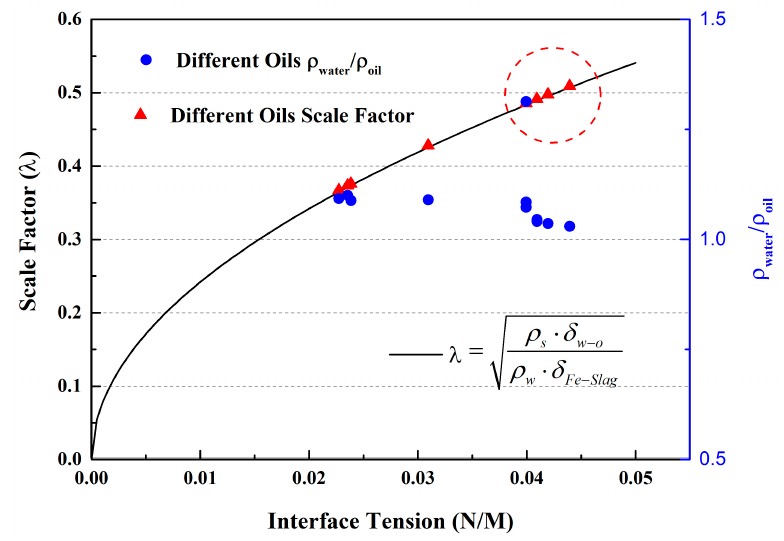
Figure 10. Relations between surface tension of different oil and scale factor.